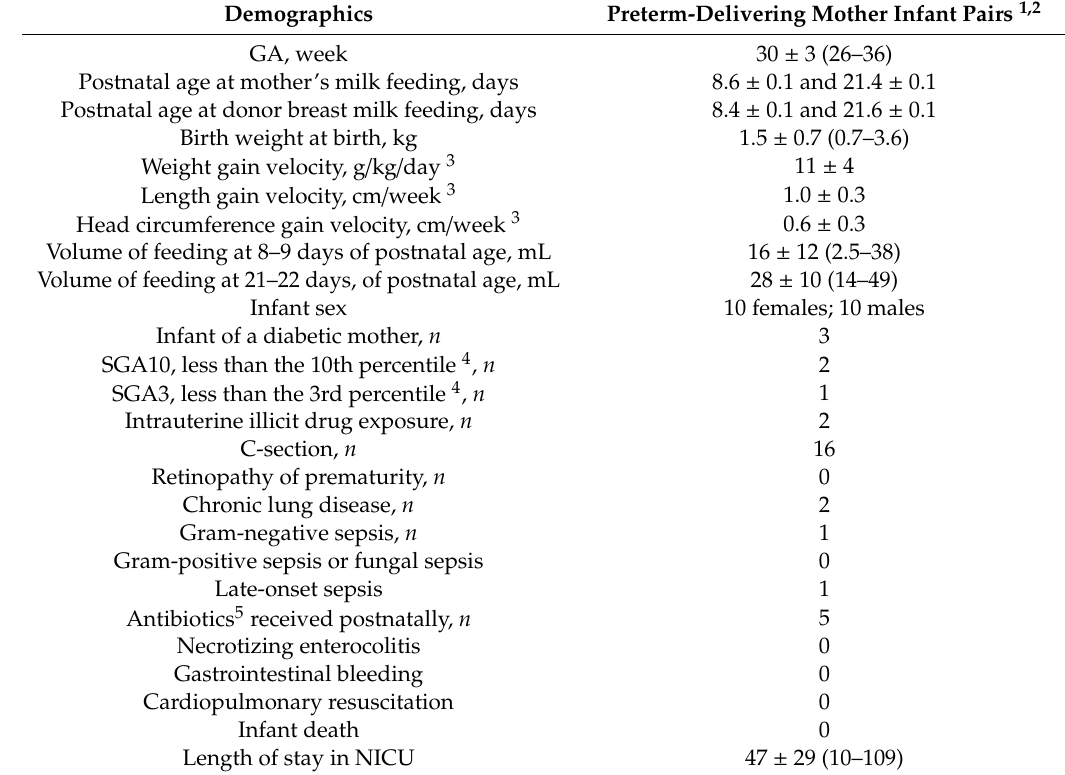
Table 1. Demographics of preterm-delivering mother–infant pairs sampled for mother’s own breast milk, gastric contents (1-h postprandial time) and stools (24-h